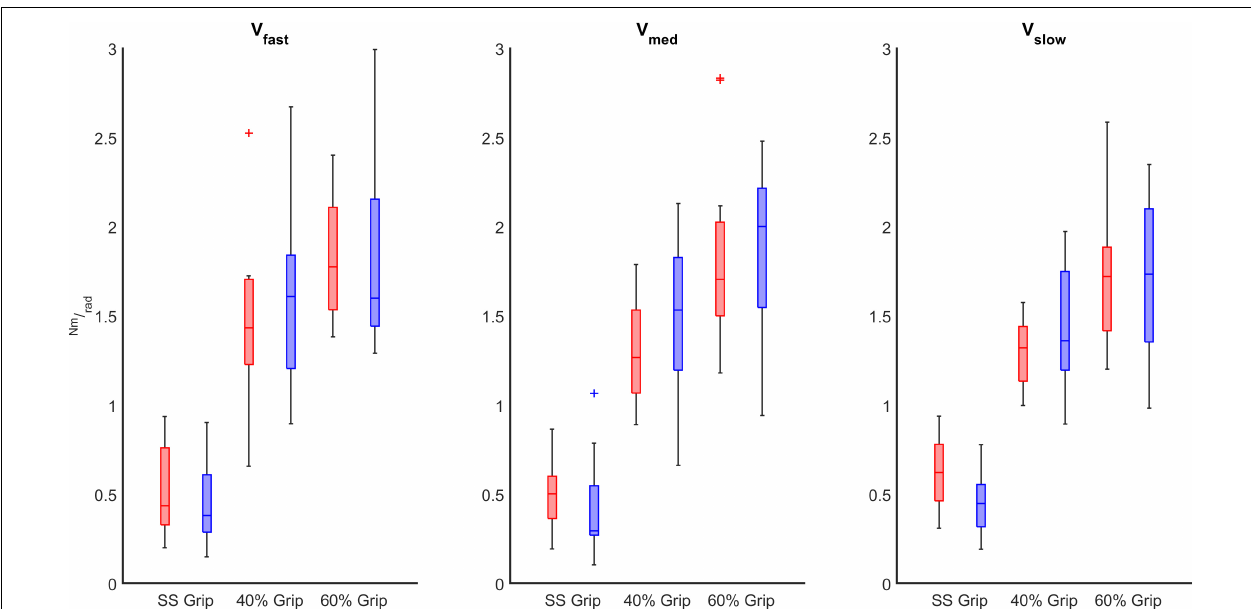
FIGURE 8 | K (Nm/rad) computed in both RH (red) and LH (blue) groups across different grip conditions considering the velocity of the perturbations (fast, medium, slow represented in the left, center, and right subplots,